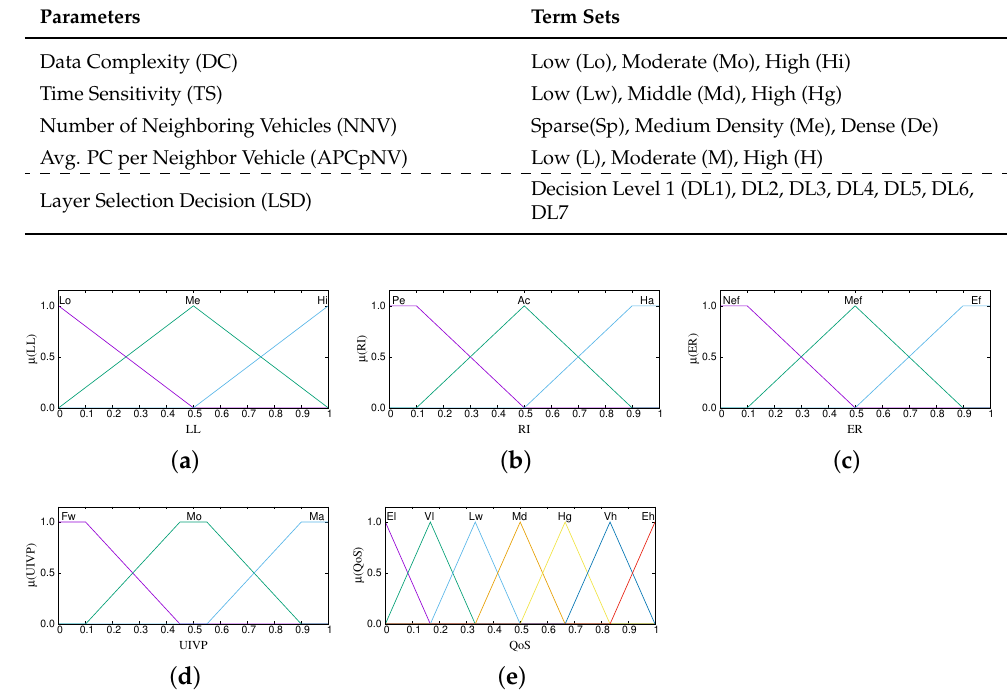
Figure 5. Membership functions of FS-AQoS. ( a ) Link Latency, ( b ) Radio Interference, ( c ) Effective Reliability, ( d ) Update Info. for Vehicle Position, and ( e ) Quality of Service.